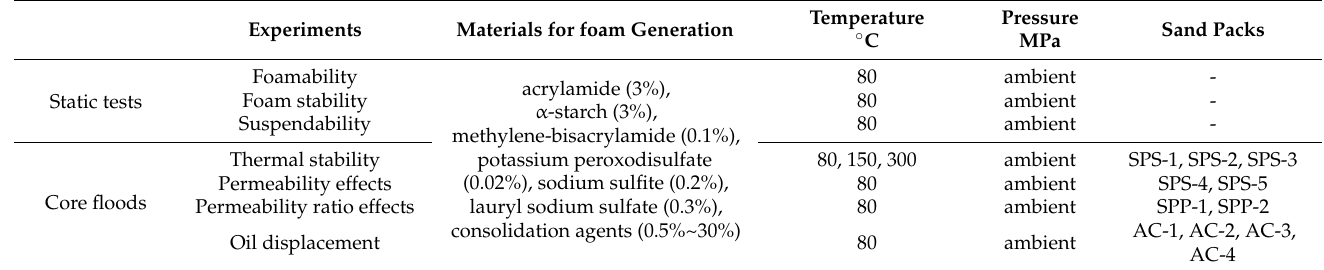
Table 3. List of